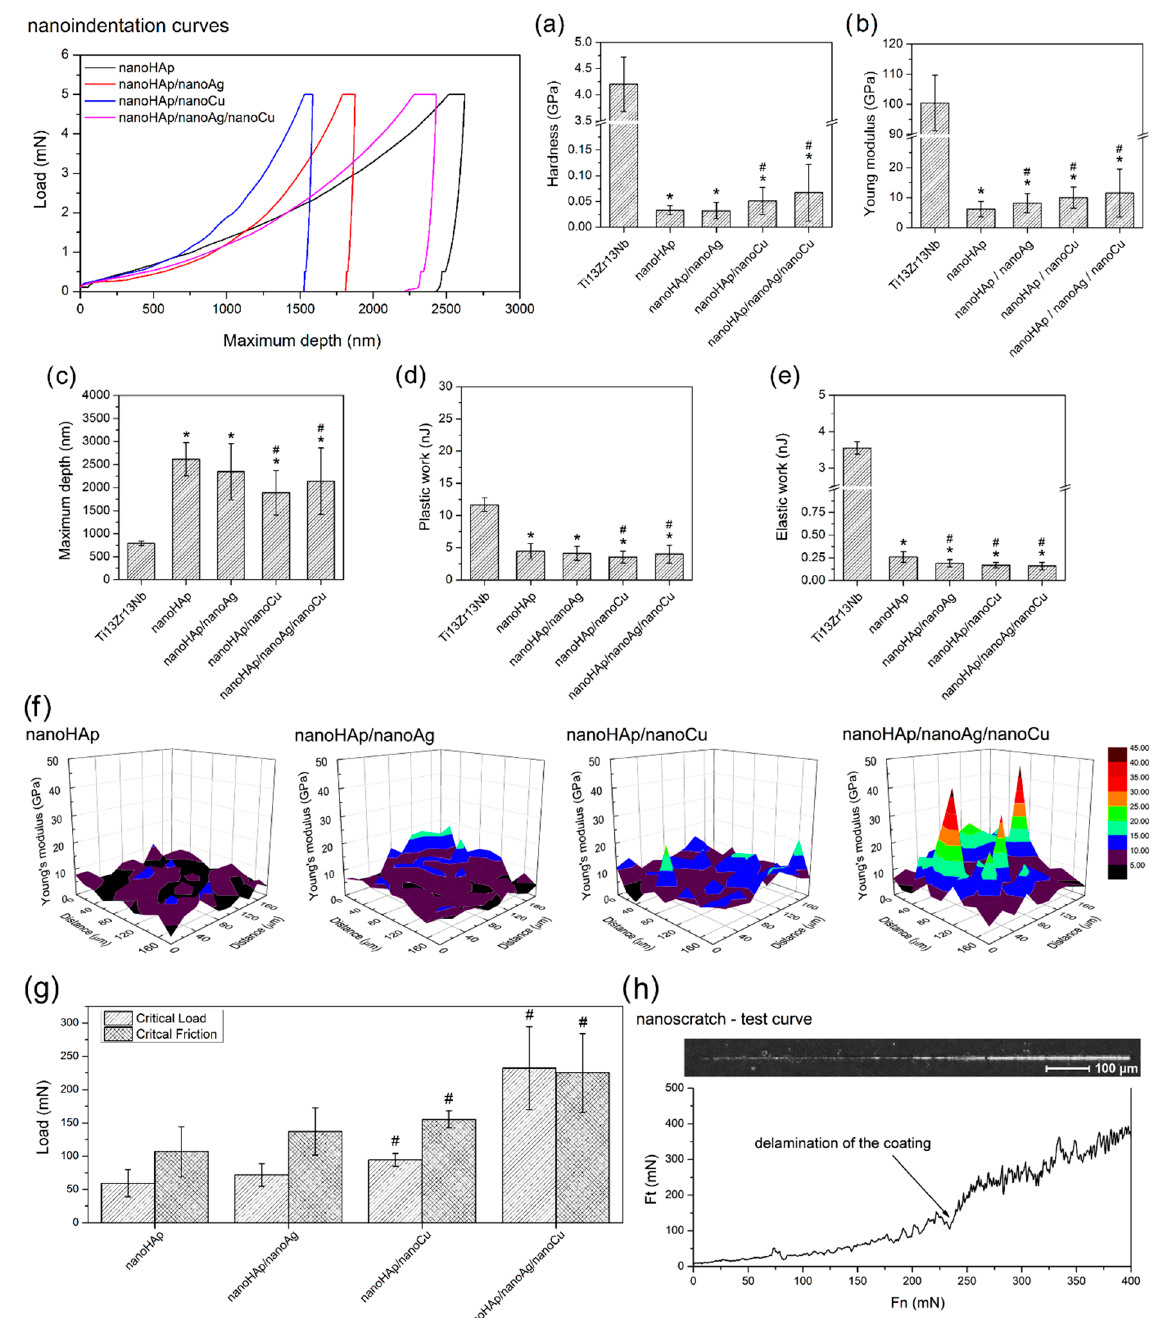
Figure 5. Nanoindentation curves and nanomechanical properties results for reference Ti13Zr13Nb alloy and nanoHAp- based coatings (( a )—hardness, ( b )—Young’s modulus, ( c )—maximum depth of indentation, ( d )—plastic work, ( e )—elastic work), maps the distribution of Young’s modulus for different coatings ( f ), nanoscratch test results ( g ), and nanoscratch test single curves for nanoHAp/nanoAg/nanoCu coatings ( h ) (* significantly different results compared to the reference Ti13Zr13Nb alloy, # significantly different results compared to the nanoHAp coating, according to one-way ANOVA test followed by Tukey’s multiple comparison test, p <0.05).